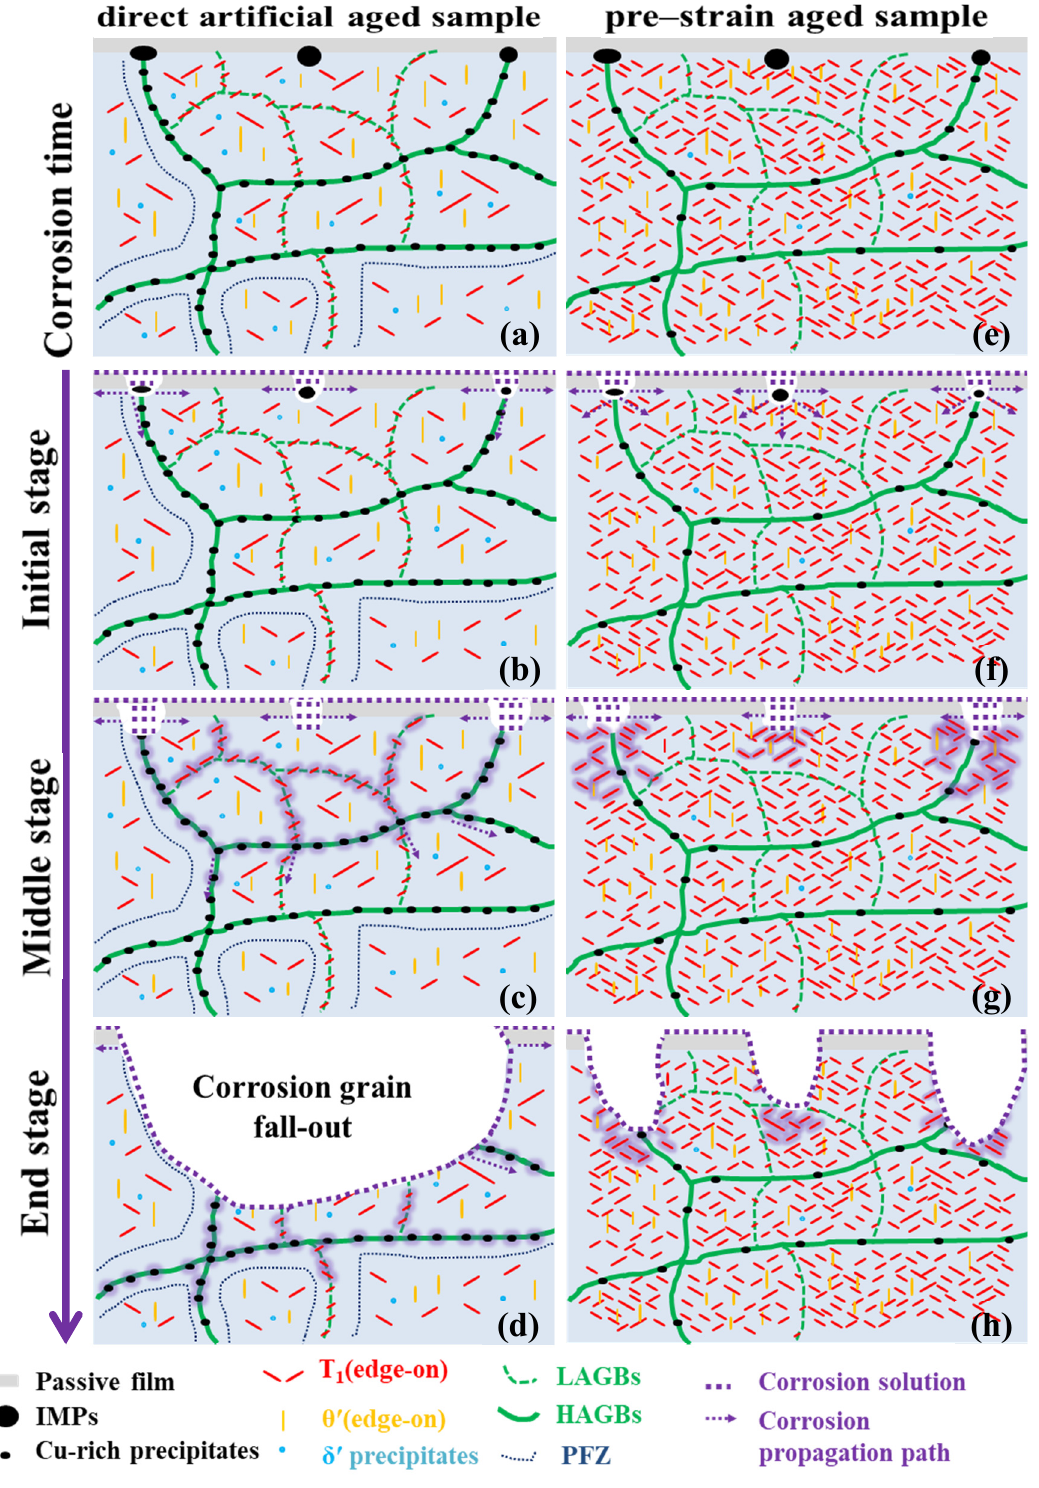
Figure 10. Schematic diagrams of corrosion process in Al–Cu–Li alloy: ( a – d ) direct artificially aged sample; ( e – h ) pre-strain-aged sample; ( a , e ) typical microstructure of samples; ( b , f ) initial stage of corrosion; ( c , g ) middle stage of corrosion; ( d , g ) end stage of corrosion.